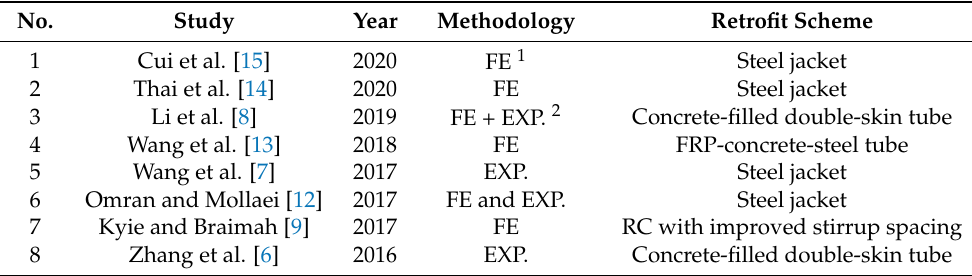
Table 1. Summary of recent studies on strengthening of columns against blast